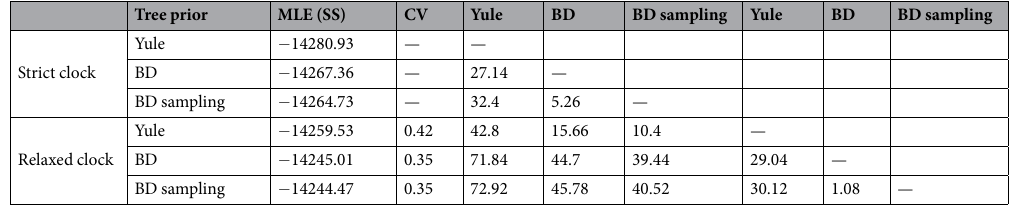
Table 1. Results of the molecular dating analyses comparing tree speciation models for relaxed and strict molecular clocks. Marginal likelihoods of estimates were performed under BEAST and the stepping-stone sampling (SS). BD stands for birth-death